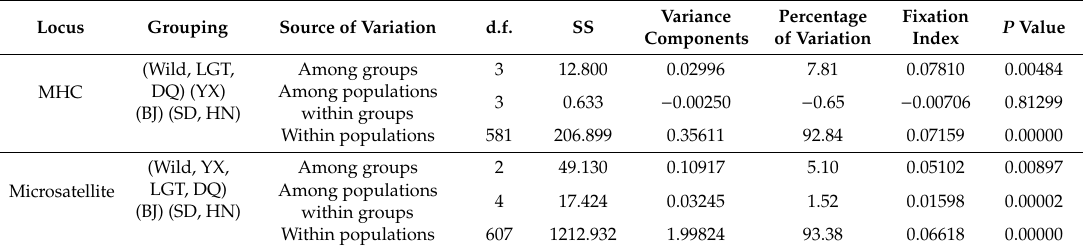
Table 3. Results from AMOVA of MHC haplotypes and microsatellite